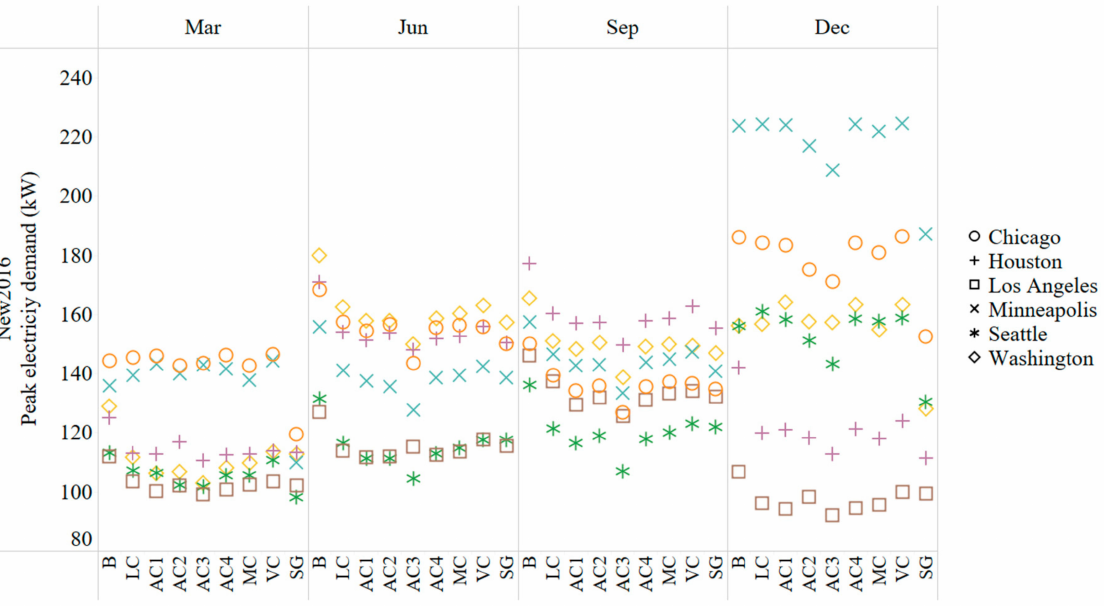
Figure 5. Peak demand for New2016 vintage.